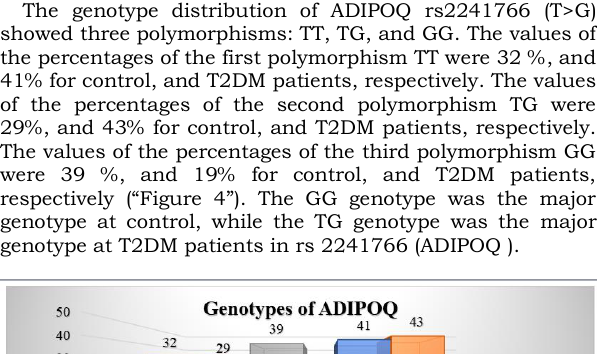
“Table. 3” calculated from “Figures 1 and 2”.